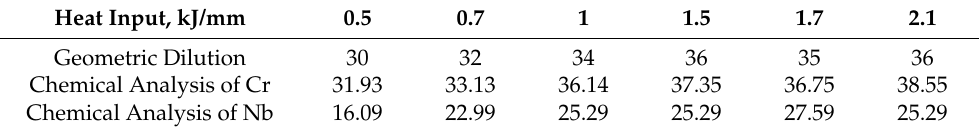
Table 5. Data of dilution determined by both geometric measurements and chemical analysis.